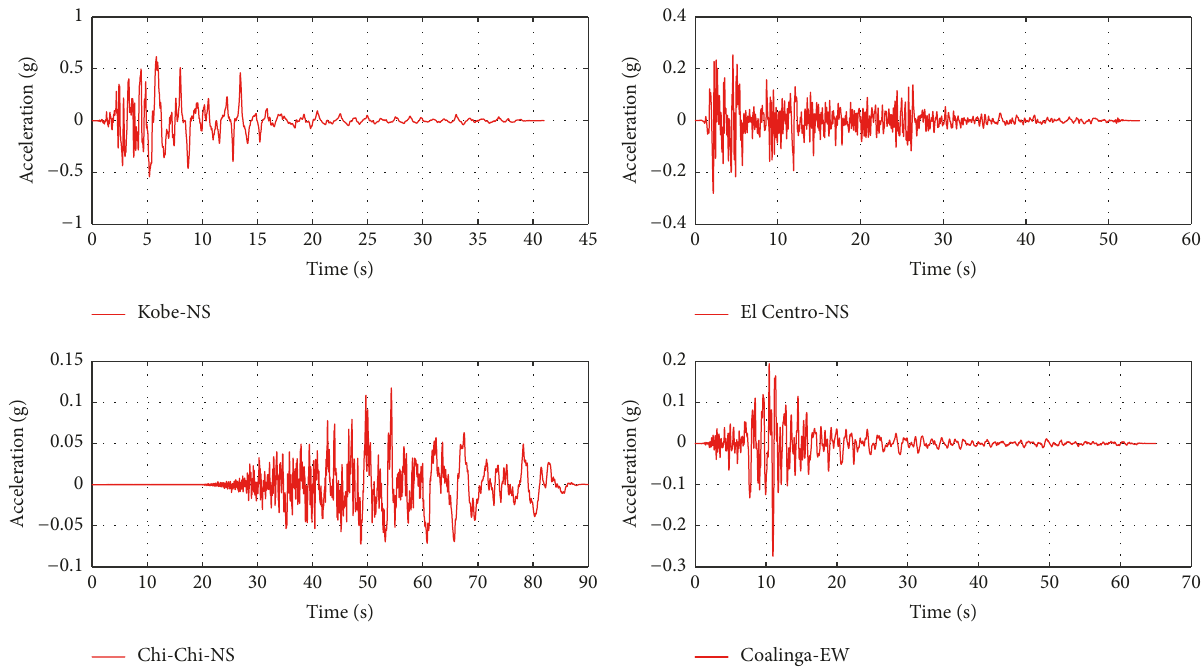
Figure 8: Time histories of the ground motions considered in this study.